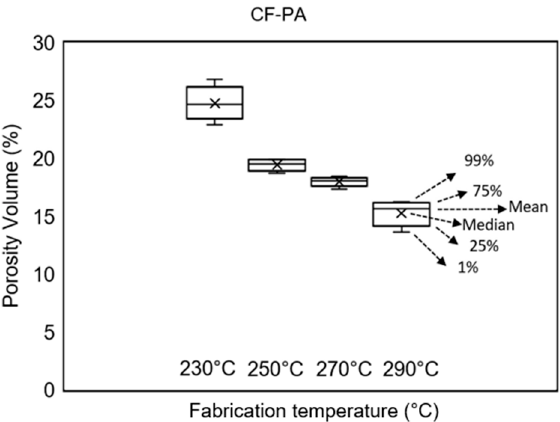
Figure 7. Fabrication temperature-related porosity volume in AM-fabricated CF-PA composite.